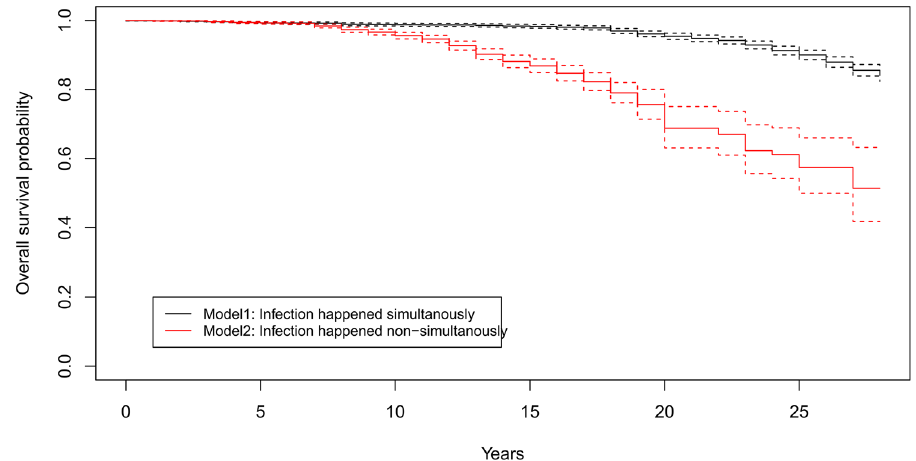
Figure 4. Kaplan-Maier survival function and overall survival probabilities for two different models (black: infection started in 1992 reegardless of country, red: infection happened delayed with distinct infection timepoints in European countries). For Model 2 we assumed infection start of single countries according to dates of first arrival published in Vasaitis &Enderle 2017.